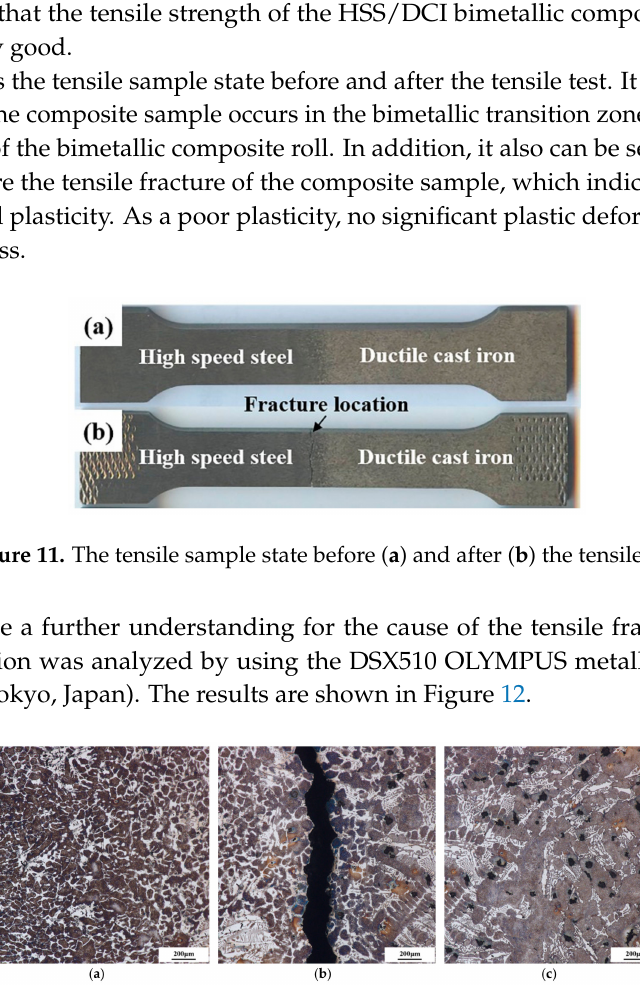
Figure 12. Microstructure of the tensile fracture of the composite specimen. ( a ) Towards the HSS side; ( b ) Fracture position; ( c ) Towards the DCI